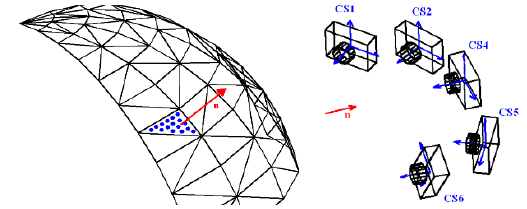
Fig. 7. Densification of the seed model (left) and selection of the master image, i.e. image CS4 in this case (right).